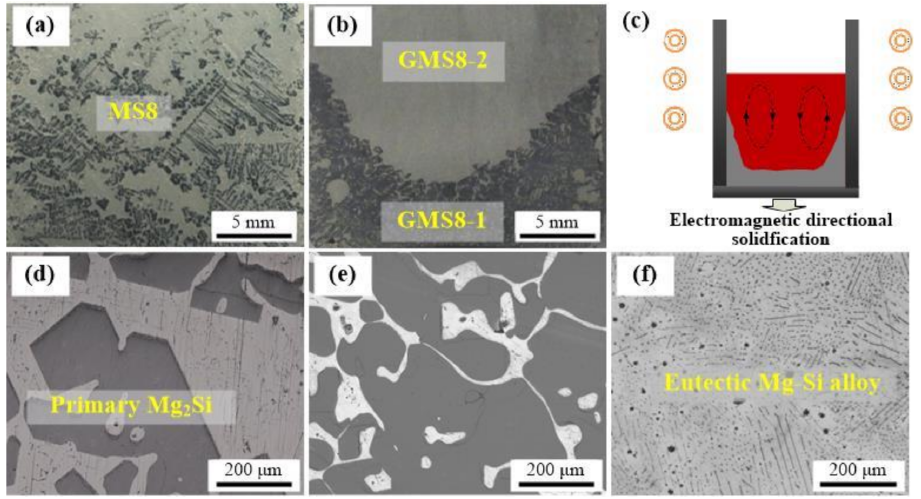
Figure 2. Macroscopic appearance of MS8 ( a ), GMS8-1and GMS8-2 ( b ) in longitudinal direction; schematic diagram of electromagnetic directional solidification ( c ); microstructures of MS8 ( d ), GMS8-1 ( e ), GMS8-2 ( f